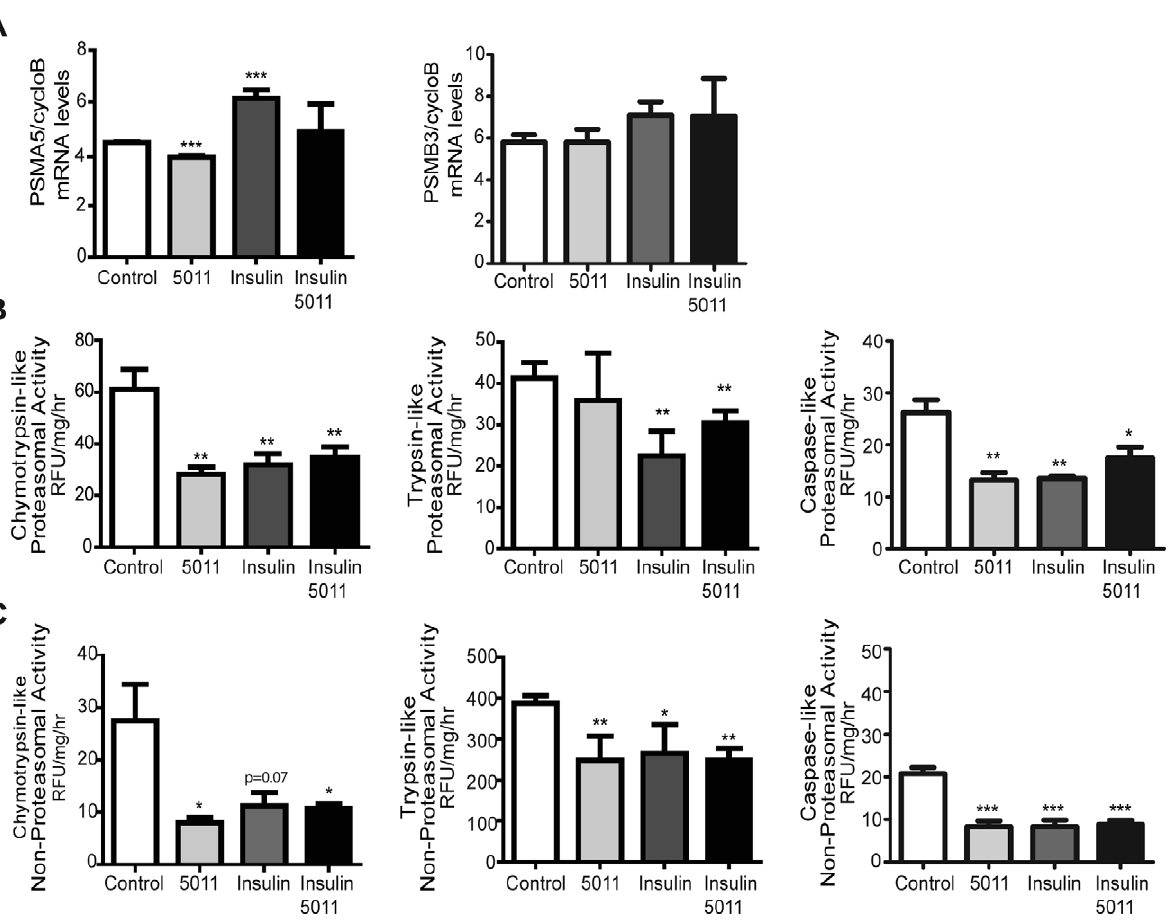
Figure 5. PMI5011 regulates proteasome and non-proteasome protease activity in skeletal muscle. At the end of the study, the KK-A y mice were fasted for 4 hours and insulin (1.5 U/kg) or an equal volume of sterile PBS was administered by intraperitoneal injection to a subgroup (N=4) of the control or PMI5011 supplemented (N=4) mice. Skeletal muscle tissue (gastrocnemious) was harvested 90 minutes thereafter. (A) Gene expression of two proteasome subunits, PSMA5 and PSMB3, was analyzed by realtime RT-PCR. (B) The chymotrypin-like, trypsin-like and caspase-like 26S proteasome activities were assayed in a buffer containing MgATP to maintain the 26S proteasome structure. (C) Non-proteasomal protease activity was assayed as the chymotrypsin-like, trypsin-like or caspase-like activity measured in the presence of epoxomicin (20 m M), a highly specific proteasome inhibitor. Proteasome and nonproteasome activities are reported as RFU/ m g protein/hr. The data are reported as the mean 2 / + standard deviation (4 animals/group). Statistical significance is compared to control. * p , 0.05, ** p , 0.01, *** p , 0.001.